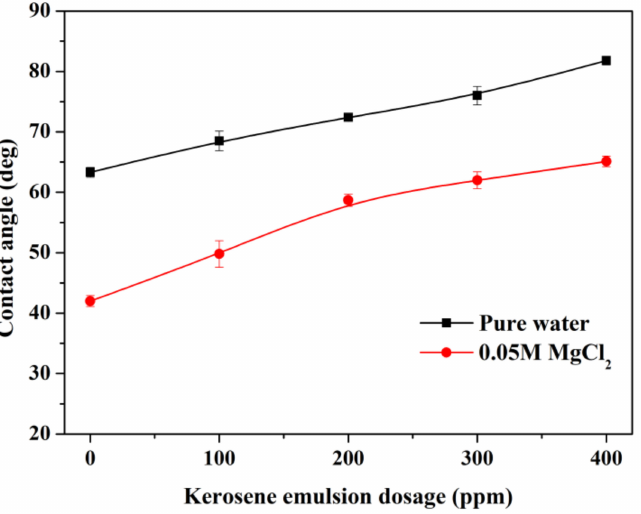
Figure 2. Contact angles of the chalcopyrite’s surface in pure water and 0.05 M MgCl 2 solution at pH 10, as a function of kerosene emulsion